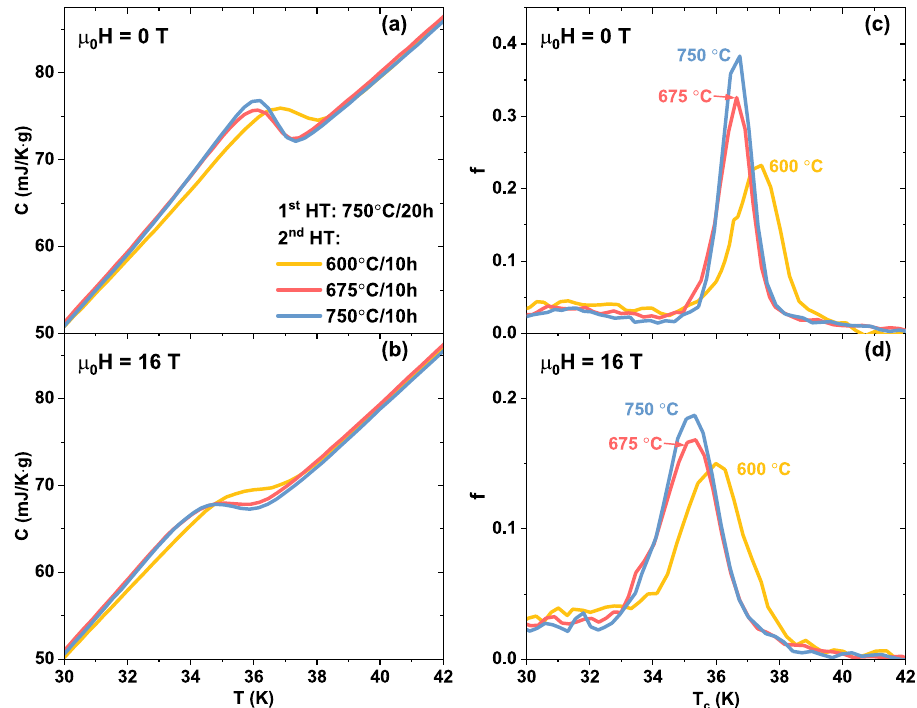
Figure 4. Specific heat transitions and T c -distribution of the K-Ba122 samples prepared varying the 2nd HT temperature. ( a , b ) magnification of the main superconducting transitions at 0 and 16 T. ( c , d ) correspondent T c - distributions calculated as explained in the text.